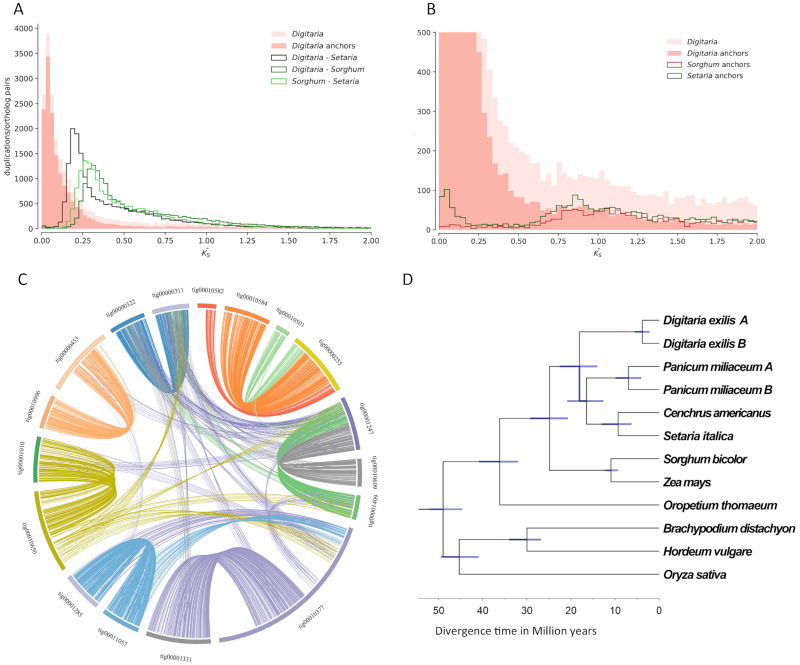
Whole-genome duplication and polyploidy analysis. (A) Ks estimation of age distribution for paralogs and orthologs of white fonio (Digitaria) and some close relatives. The distribution in light pink represents the entire white fonio paranome, while the distribution in darker pink represents the anchor points (duplicated genes lying in syntenic or collinear regions; see C). Distributions in black, dark green, and light green represent the 1-vs-1 ortholog comparisons between Digitaria-Setaria, Digitaria-Sorghum, and Sorghum-Setaria, respectively. (B) Ks distributions for paralogs of white fonio, sorghum, and Setaria (zoom in), showing an older, likely Poaceae-shared, WGD. (C) Syntenic relationships between putative homoeologous contigs, with colored lines connecting homoeologous gene pairs in the white fonio genome assembly. (D) Time-calibrated phylogenetic tree of several major Poaceae lineages, including white fonio, based on 1,242 gene families consisting of a single gene copy in each lineage and an anchor pair (A and B) in Digitaria. The time scale is shown in million years (My). See text for details.